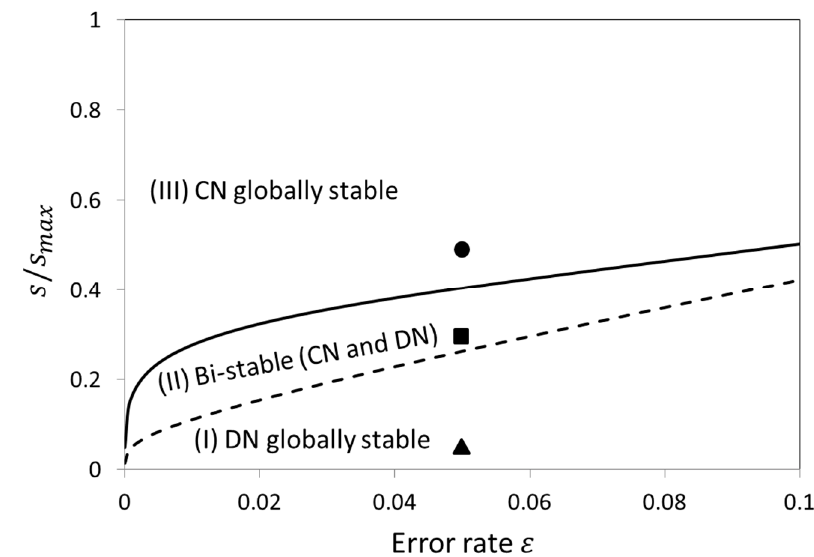
) for prospect theory: (I) DN is globally Figure 3. Different domains in the parameter space ( ε , s s max stable (under the dashed line) in the case of the prospect theory, (II) both CN and DN are stable (the region sandwiched by the solid and dashed line). (III) CN is globally stable (the region above the solid line). In the parameter region shown in the figure, DN is globally stable in the case of the linear expected utility theory. The solid triangle in the figure corresponds to the parameter set ( ε = 0.05, s = 1 ) used to generate Figure 2a, the solid square to ( ε = 0.05, s = 6 ) , which was used to generate Figure 2b and the solid circle to ( ε = 0.05, s = 10 ) for Figure 2c. We see that CN becomes stable as s becomes larger for each error rate. However, the boundaries depicted by solid and dashed curves are monotonically increasing functions of error rate ε